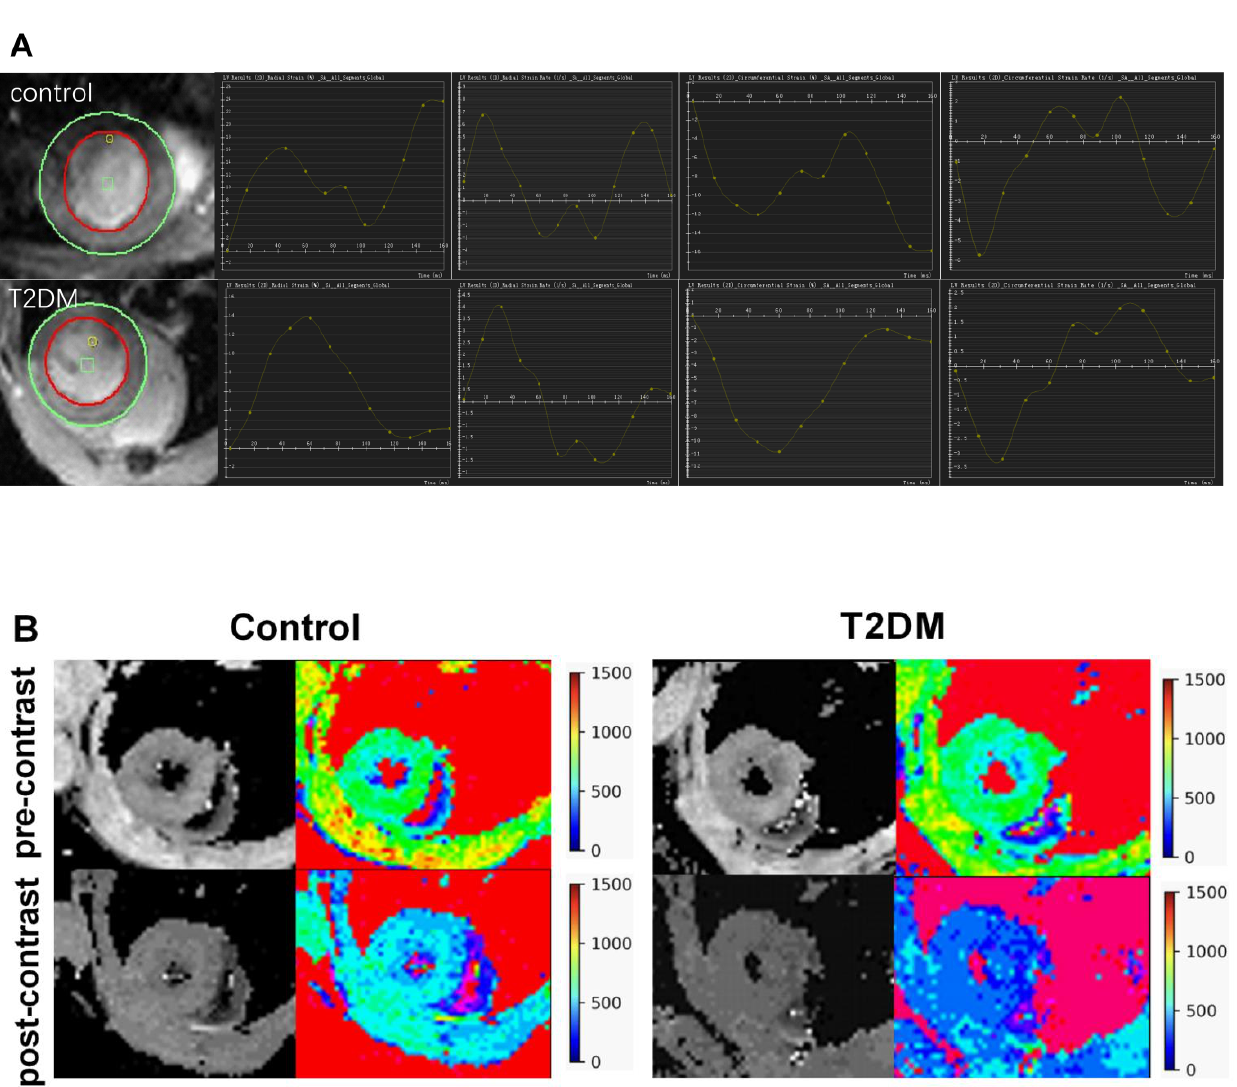
Figure 1. Feature tracking strain analysis and ECV map in representative T2DM mice and control. ( A ): The first column on the left shows the cine image of the mouse heart. The curves show the change in the left ventricular myocardial strain and strain rate with the cardiac cycle. ( B ): T1 mapping images and pseudocolor maps of mouse hearts. ECV: extracellular volume.